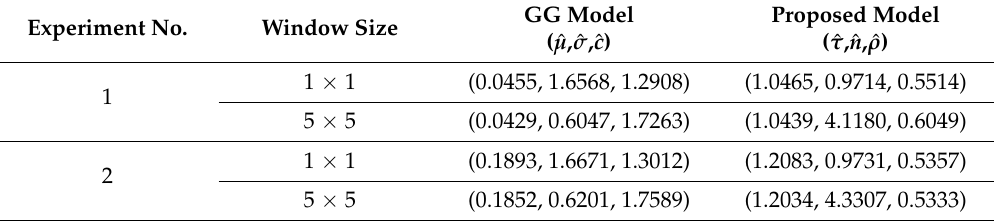
Figure 5. Fitting results of the proposed model for the data shown in Figure 3: ( a , b ) are the results for a 1 × 1 filtering window displayed on linear and semi-log scales, respectively; ( c , d ) are the results for a 5 × 5 filtering window displayed on linear and semi-log scales, respectively. Table 1. Parameter estimations with different window sizes. GG: generalized Gaussian. Experiment No. Window